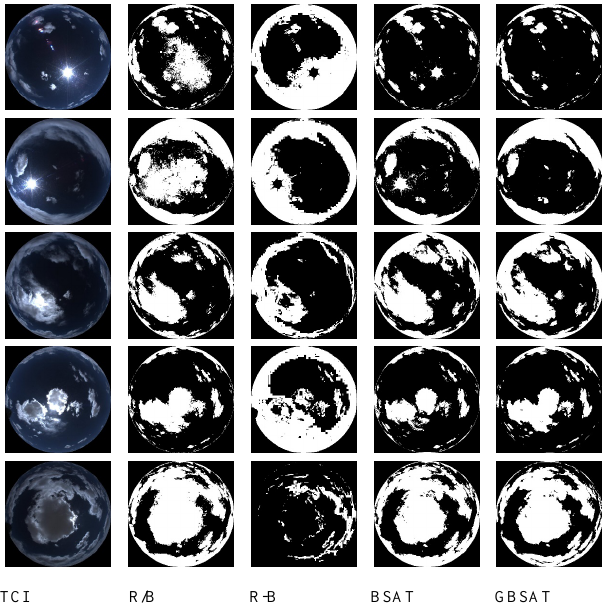
Figure 9. Results comparison for different cloud detection